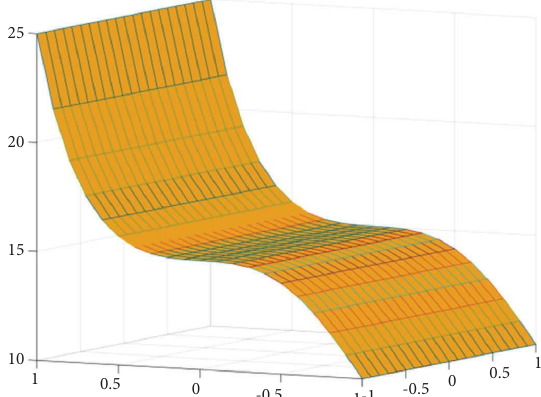
Figure 6: Te correlation of r and SO ( G )